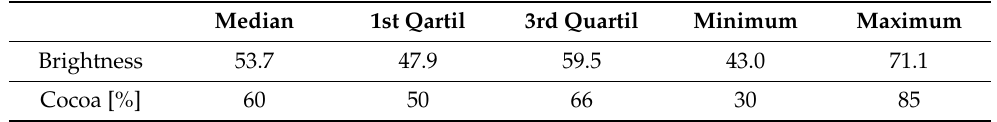
Table 2. The brightness of the chocolate and the cocoa content in the